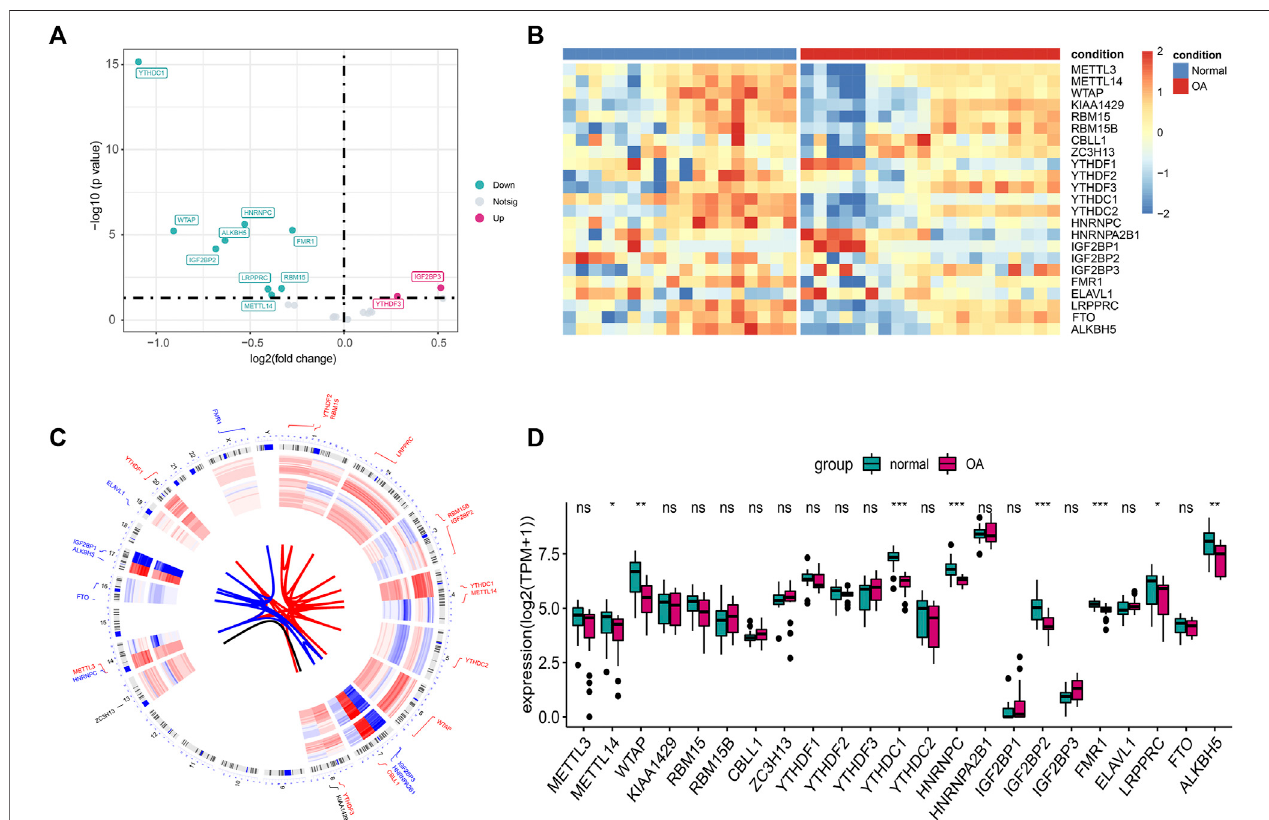
FIGURE 2 | Expression differences of m6A genes in OA. (A) The volcano plot of m6A gene difference: the abscissa is log2FC, and the ordinate is − log10( p -value). (B) Heat map of m6A gene differences. (C) Chromosome circus map of differential expression of m6A gene, the inner circle is the expression heat map of OA samples, and the outer circle is the expression heat map of normal samples. (D) Boxplot of m6A gene differences. (ns: p > 0.05, *: p < 0.05, **: p < 0.01, ***: p < 0.001).